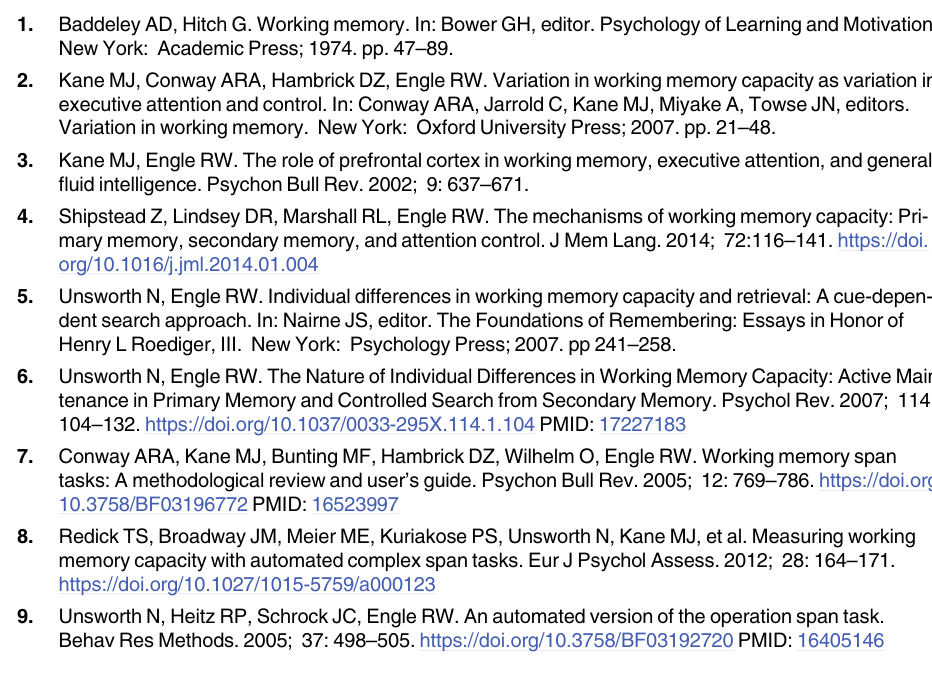
S1 Fig. Scatter plots of correlations among PCS and measures of intelligence according to the working memory (WM) span task and accuracy criterion on the processing compo- nent of the task. Panel (A): scatter plots for OSPAN and RSPAN. Panel (B): scatter plots for SSPAN.